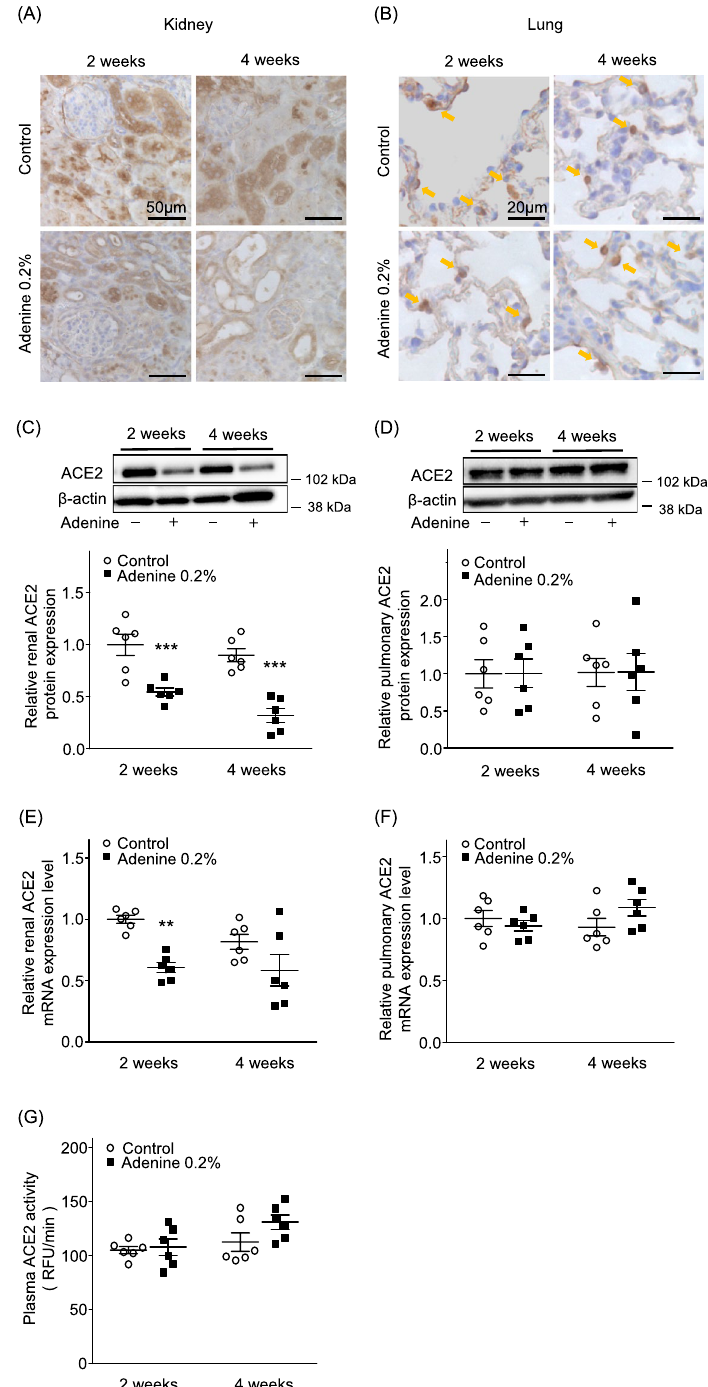
Figure 2. Renal and pulmonary ACE2 expression levels and plasma ACE2 activity in adenine-induced CKD mice. ( A ) Representative image of renal ACE2 immunostaining at 2 or 4 weeks after treatment in adenine and control groups. Bars = 50 µm. ( B ) Representative image of pulmonary ACE2 immunostaining at 2 or 4 weeks after treatment in adenine and control groups. Bars = 20 µm. ( C ) Renal ACE2 protein expression levels and ( E ) mRNA expression levels in adenine and control groups. ( D ) Pulmonary ACE2 protein expression levels and ( F ) mRNA expression levels in adenine and control groups. ( G ) Plasma ACE2 activity in adenine and control groups. Values are expressed as mean ± standard error of the mean (six mice per group). P values, versus control: * P < 0.05; ** P < 0.01; *** P <